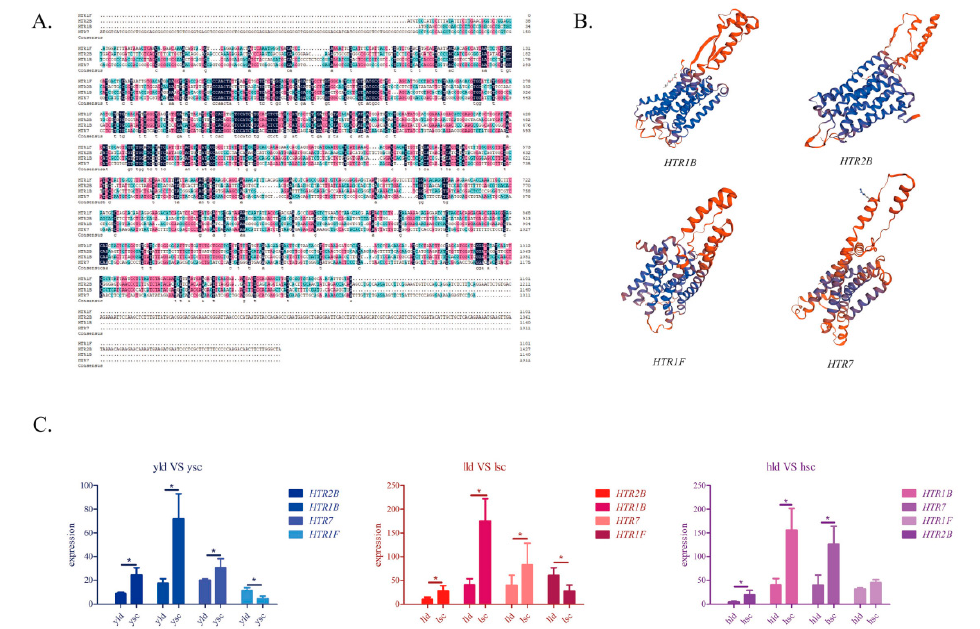
Figure 6. Sequence analysis and expression verification of HTR1B, HTR1F, HTR2B , and HTR7 . ( A ) CDS